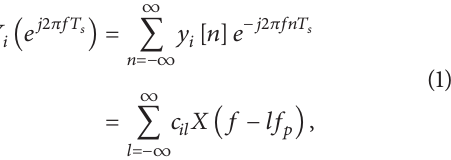
Figure 1: The sampling part of MWC structure.